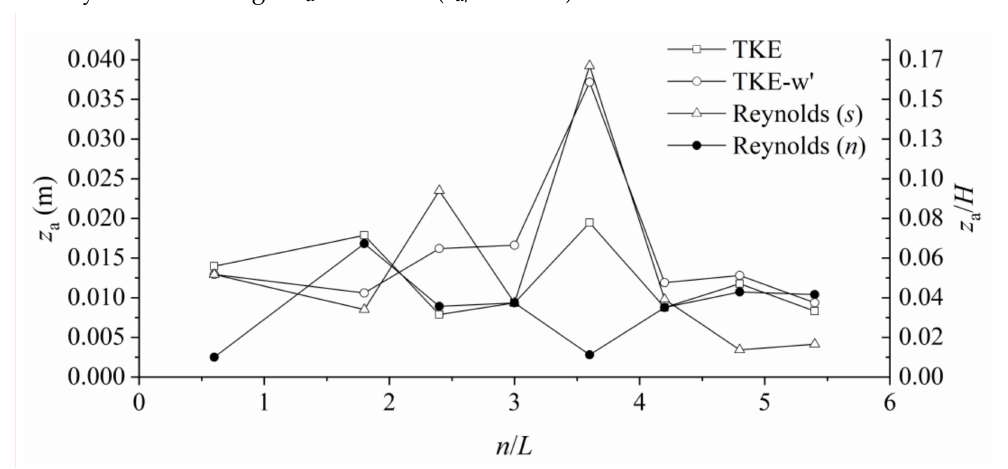
Figure 9. The peak-value heights of section S